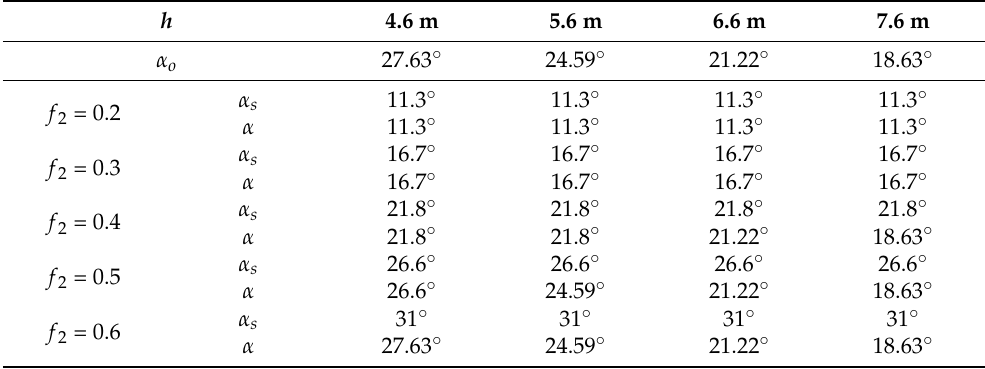
Table 2. Relationship between support–floor friction f 2 and critical angle α of lateral stability of single support.